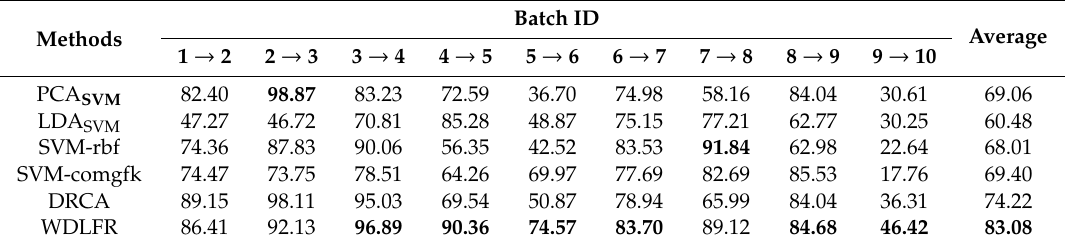
Table 4. Recognition Accuracy (%) under Experimental Setting 2. The bold font represents the highest recognition accuracy of a batch in all compared algorithms.